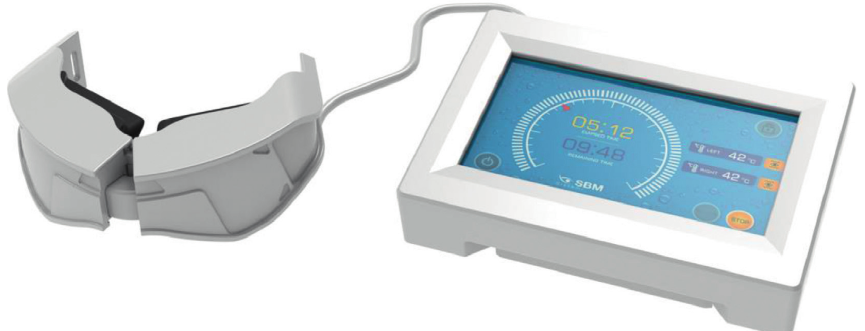
Figure 1: The eye mask Activa (SBS Sistemi, Turin, Italy).